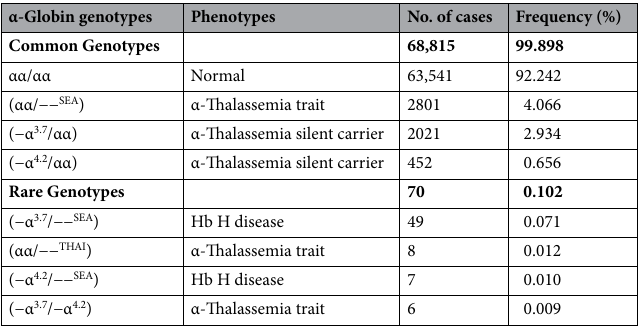
Table 1. α-Globin genotypes in the study population. Total values for Common Genotypes and Rare Genotypes are in [bold].